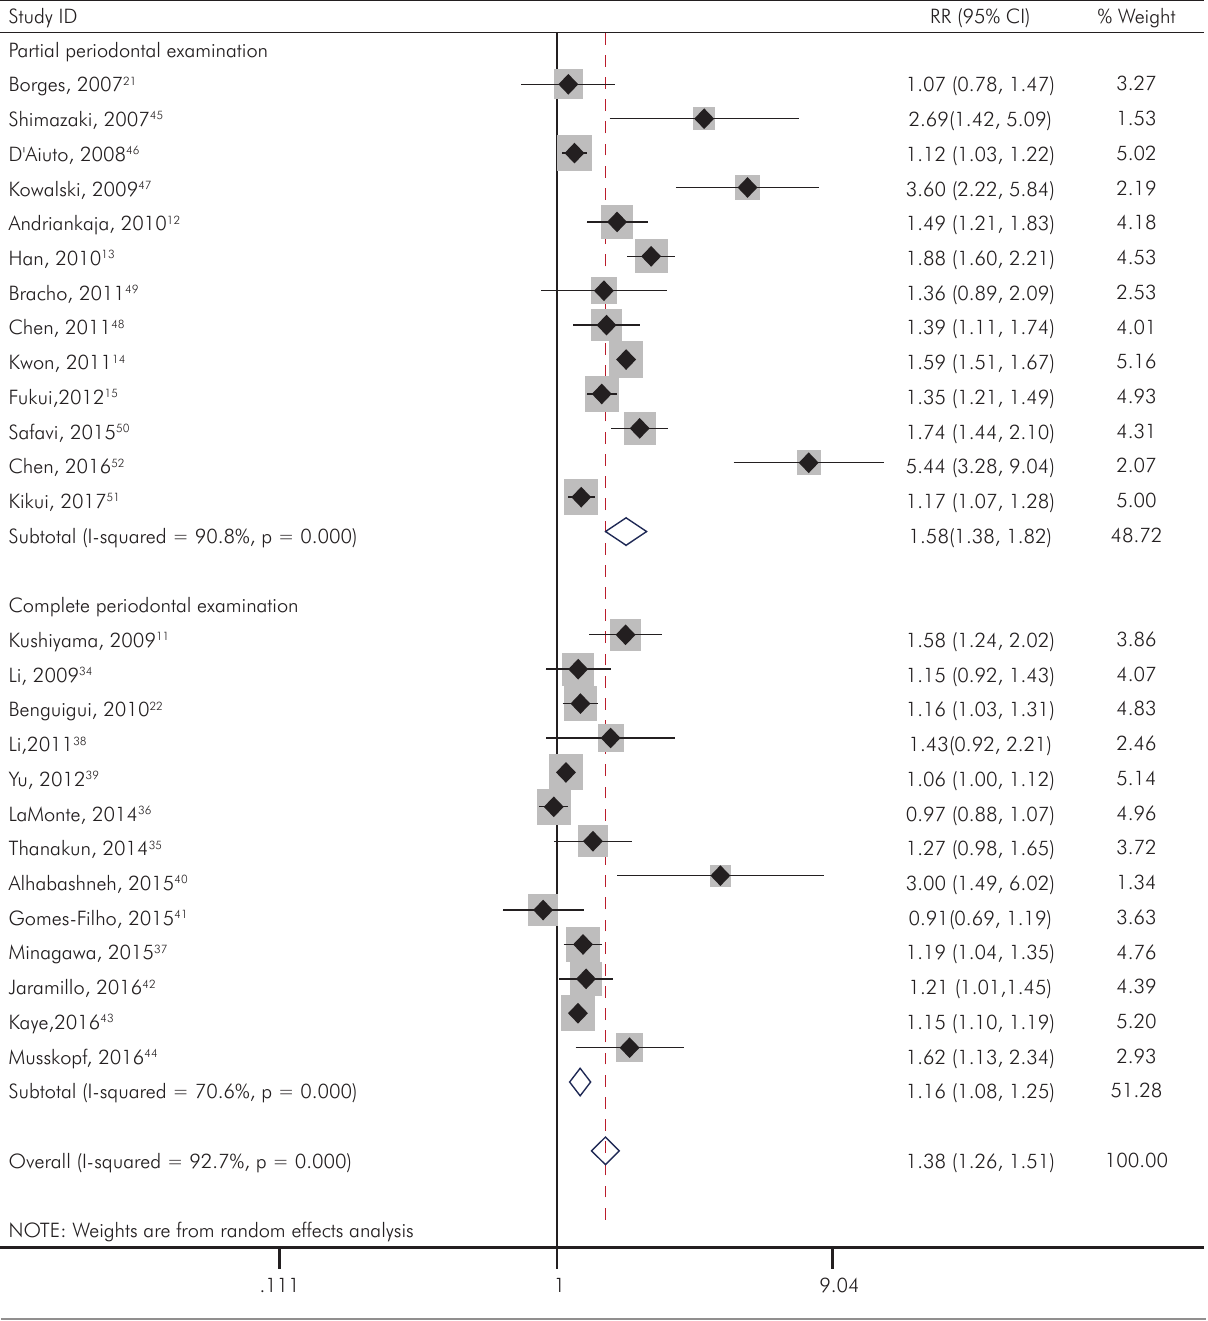
Figure 3. Subgroup analyses with complete and partial periodontal